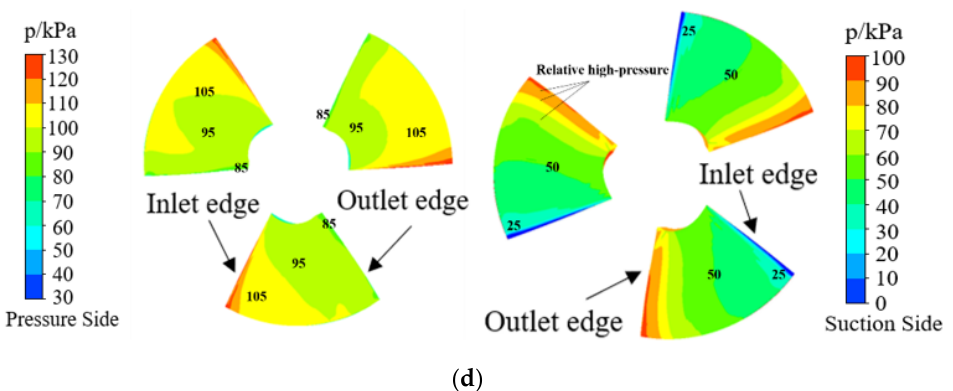
Figure 10. Pressure distribution contours of the pump impeller blades at different times: ( a ) t = 0.5 s; ( b ) t = 1.5 s; ( c ) t = 2.0 s; ( d ) t = 3.0 s.